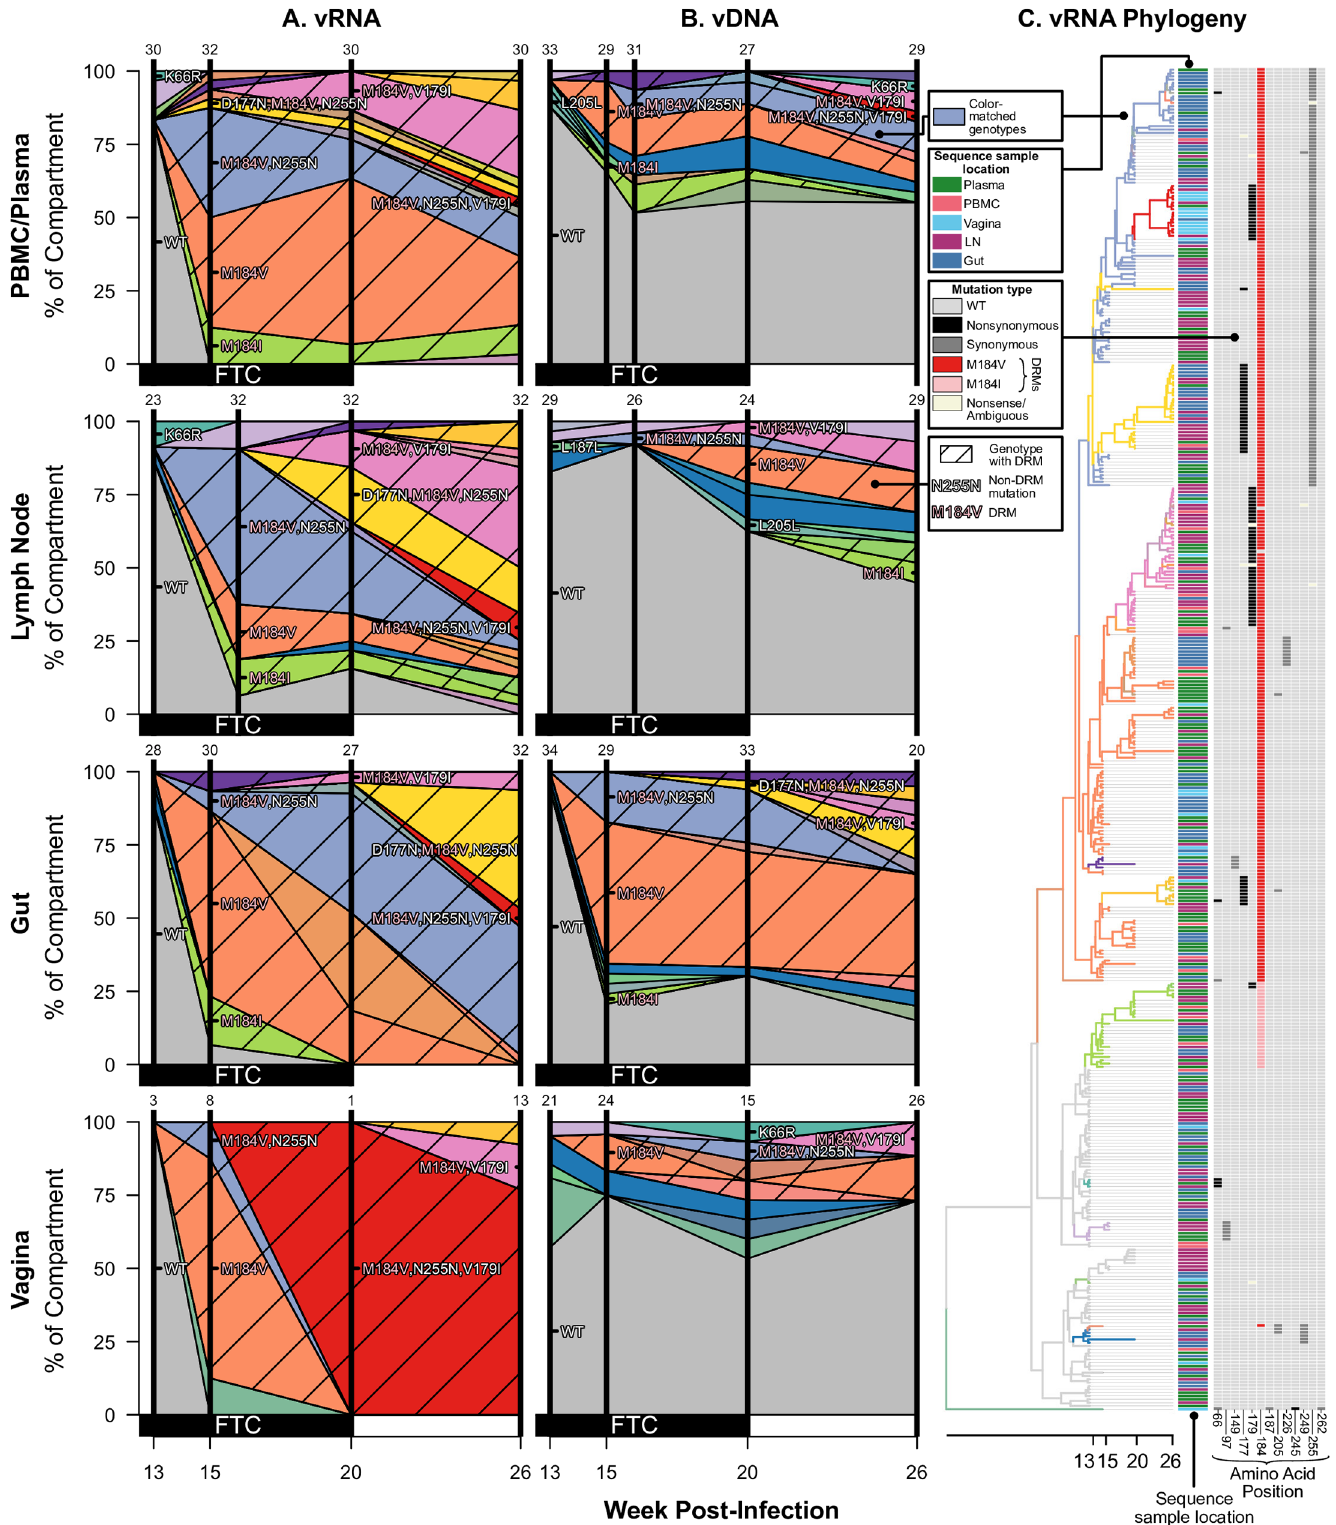
Fig 3. Drug resistancespreads dynamically across severalcompartments in macaque T98133over the course of treatment. Coloredpolygons show the prevalence of different genotypes of RT-SHIV RNA (A) or DNA (B) over time in different compartments. Vertical distanceat black vertical lines